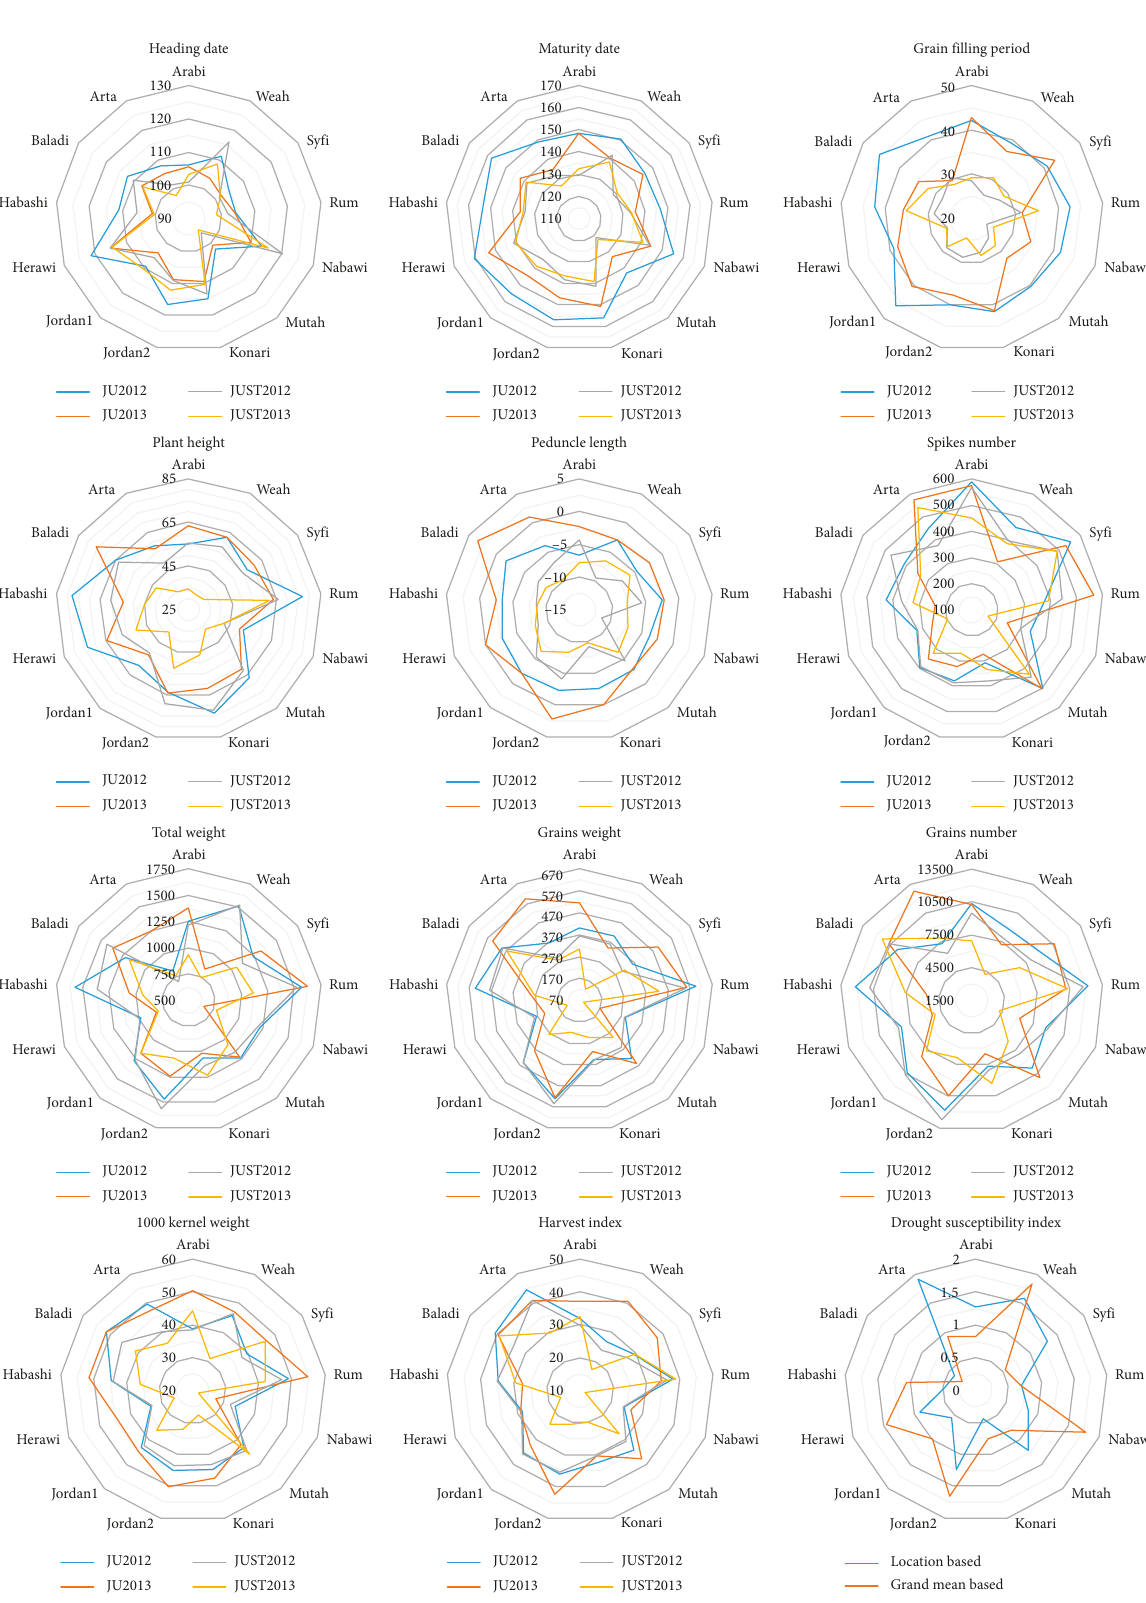
Figure 1: Agronomical performance of 13 barley genotypes evaluated in four tested environments as represented in 11 recorded traits and drought susceptibility index analysis based on location and grand